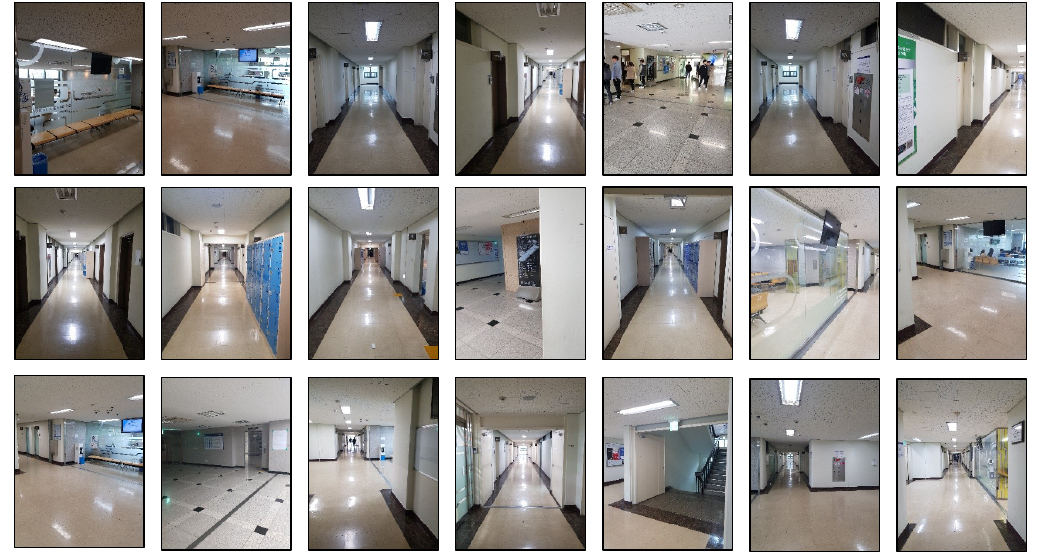
Figure 8. Indoor scenes of the experiment